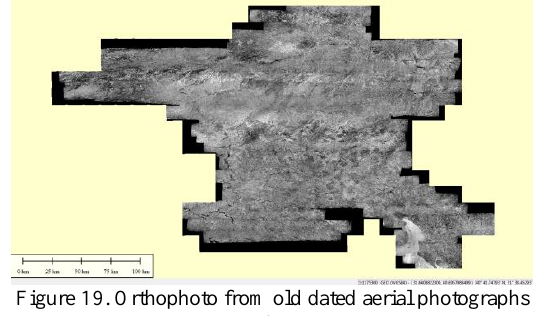
Figure 19. Orthophoto from old dated aerial